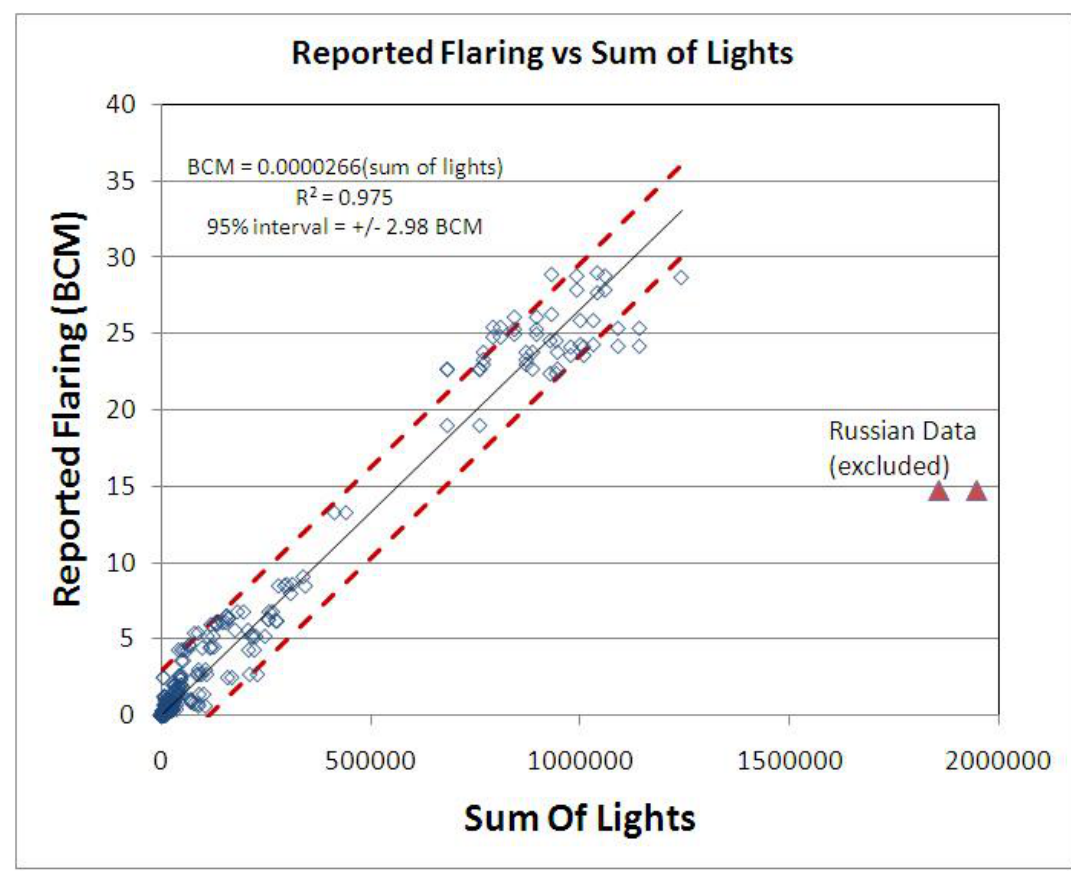
Figure 8. Plot of the reported BCM levels of flared gas versus the sum of light index, regression line (solid line) and 95% prediction intervals for individual BCM estimates (dashed red